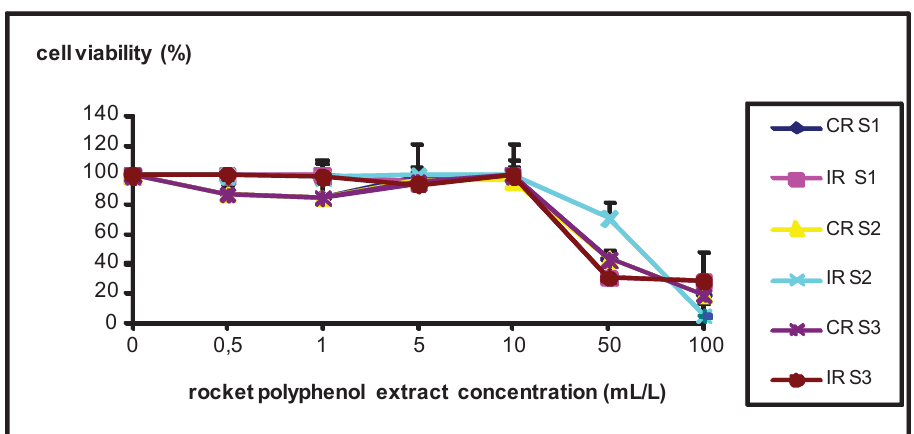
Figure 1. Effect of polyphenol rocket extract on Caco-2 cell viability